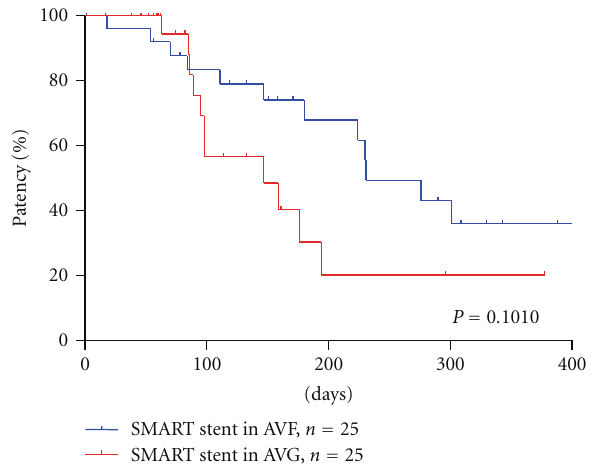
Figure 1: Primary patency rates in AVF and AVG. No significant di ff erence was observed in the primary patency rates between AVF and AVG, but patency in AVG showed inferior to AVF.